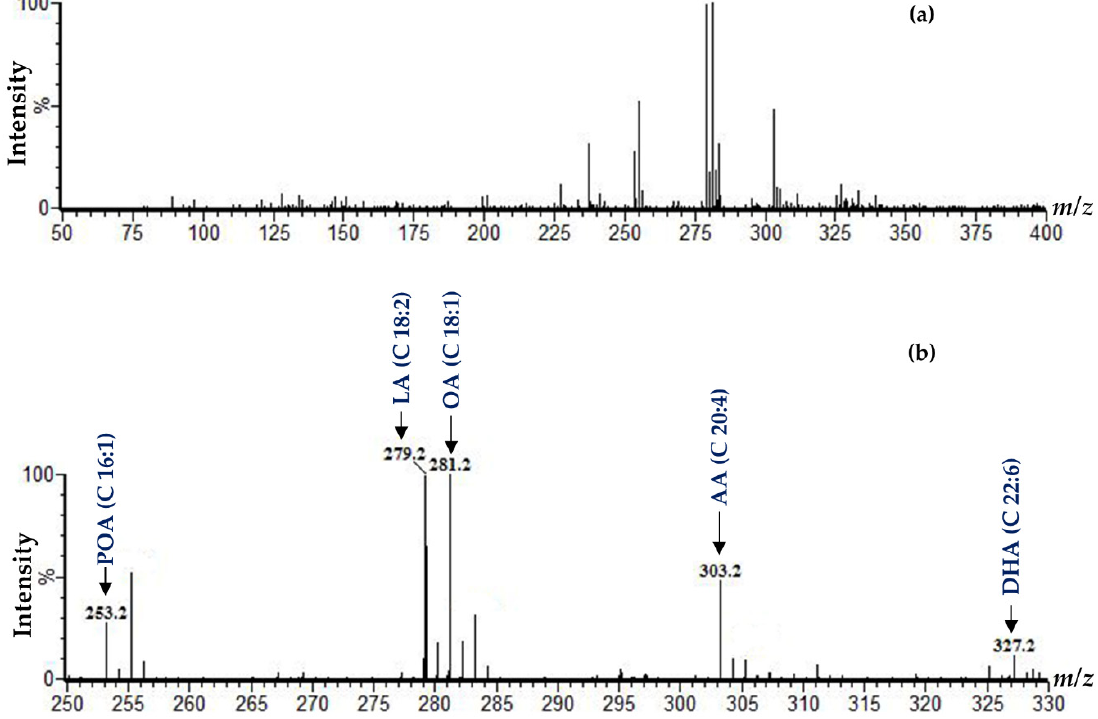
Figure 2. DESI–MSI spectra obtained from whole lip tissue of subject 1. ( a ) Full negative-ion mass spectrum from m / z 50 − 400. (b) Expanded view of the mass ranges from m / z 250 to 330 with molecular assignments. PA: palmitoleic acid; LA: linoleic acid; OA: oleic acid; AA: arachidonic acid; DHA: docosahexaenoic acid. Table 2. List of assigned peaks in the spectra of the human lip obtained by DESI–MSI in negative ion mode.